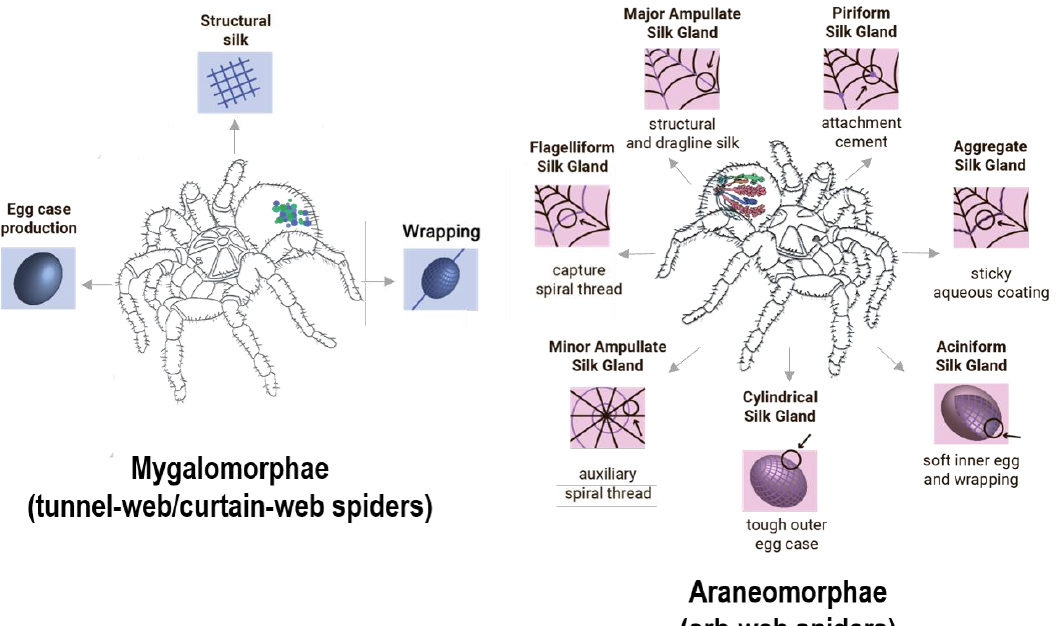
Figure 1. Schematic representation of morphological differences in spider glands between Araneomorphae and Mygalomorphae species with corresponding silk fiber